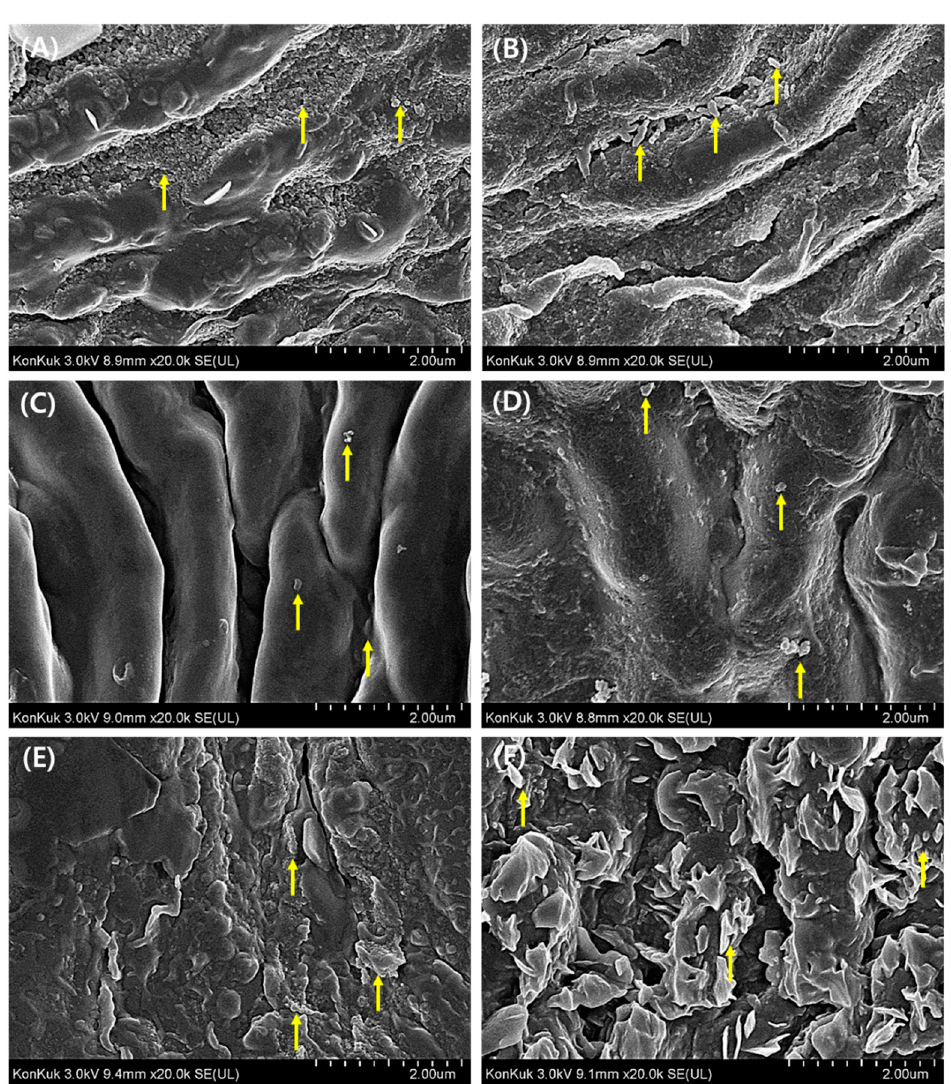
Figure 4. SEM images of adaxial surface of Ardisia japonica leaf under CL (continuous light) with ( A ) drought and ( B ) water supply, under LD cycle (light/dark cycle; 14 h/10 h) with ( C ) drought and ( D ) water supply, and under CD (continuous dark) with ( E ) drought and ( F ) water supply. Symbol ( ↑ ) indicates the distributed particulate matter.